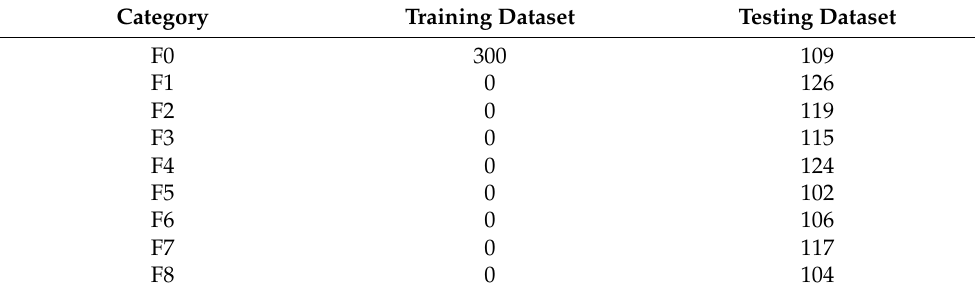
Table 1. The number of training and testing images for each